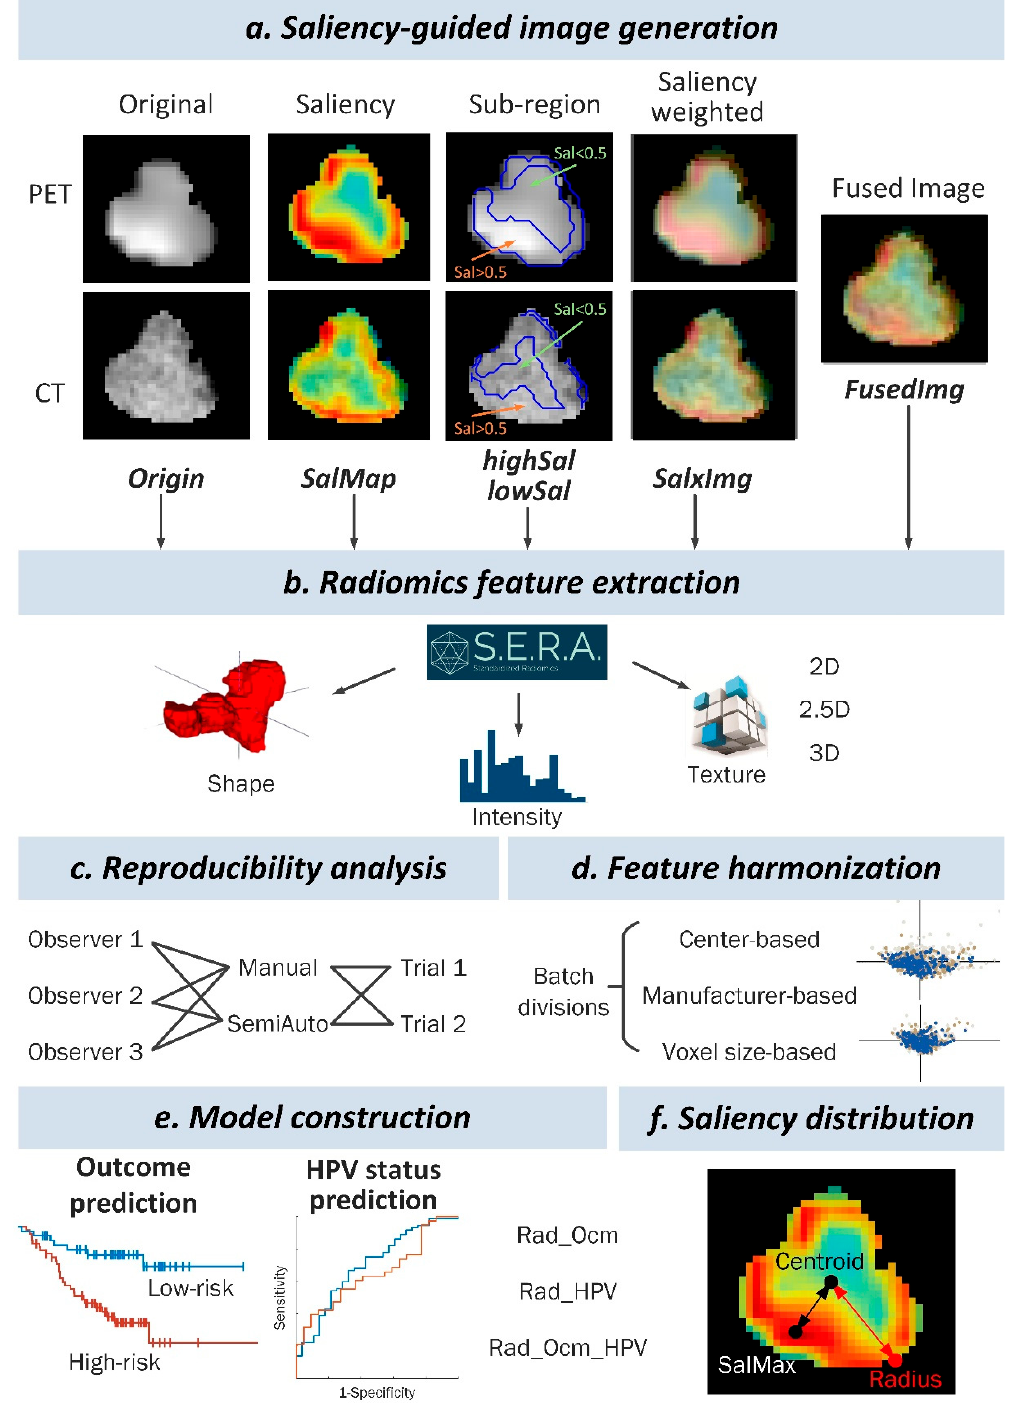
Figure 3. Overview of the investigated saliency ‐ guided radiomics analysis workflow, including sa ‐ liency ‐ guided image generation (Origin, SalMap, highSal, lowSal, SalxImg, and FusedImg), radi ‐ omics feature extraction, reproducibility analysis, feature harmonization, model construction (out ‐ come prediction and HPV status prediction), and saliency